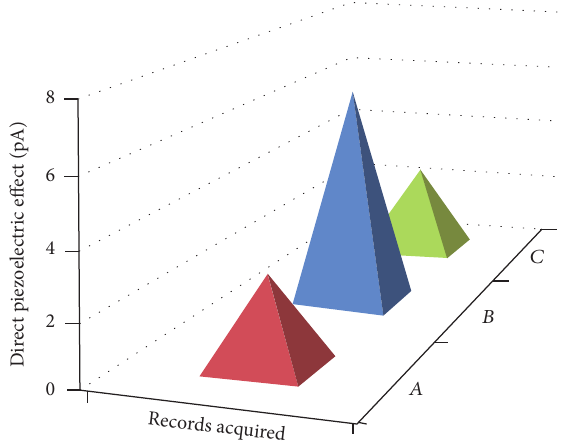
Figure 8: Piezoelectric response of PLZT ceramic with Pt implant.